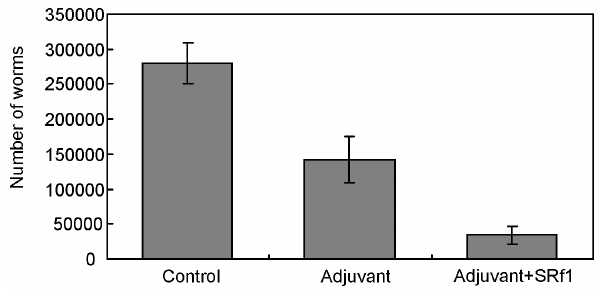
Figure 3. Challenge infection in dogs mucosally immunized with SRf1. Each dog was nasally immunized with SRf1 with CTB adjuvant 4 times. A booster was given orally 3 times with CT. Protoscoleces (5 6 10 5 ) were administrated orally after the final immunization. As controls, groups were immunized with PBS or PBS plus adjuvant. The values are the mean number of adult worms 6 the S.D. The model separating the group immunized with SRf1 plus adjuvant from the control group best fits the data according to generalized linear modeling (P ,